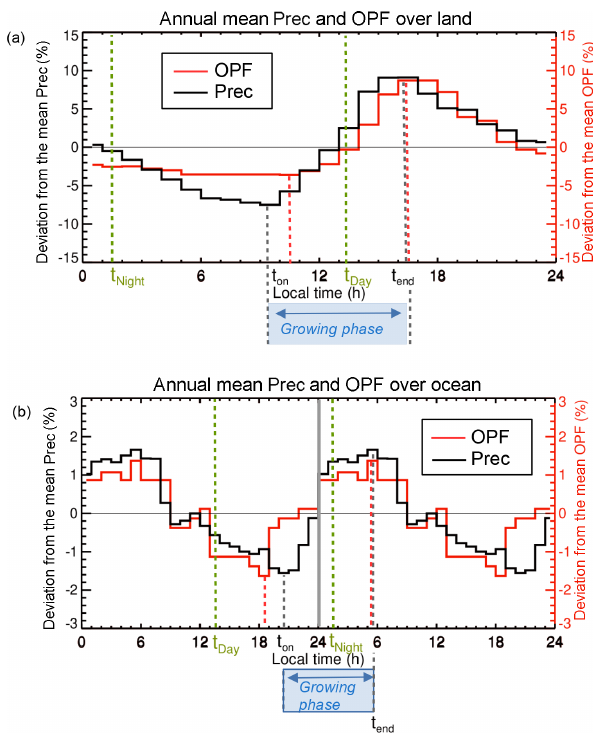
Figure 9. (a) Deviation from the mean of the annual mean diur- nal cycle of TRMM precipitation (Prec; black solid line) over land, from 2004 to 2017 and diurnal cycle of overshooting precipitation features (OPFs) at the tropopause (red solid line) over land, from 1998 to 2000 and from 2001 to 2003, adapted from Liu and Zipser (2005) over the tropics (20 ◦ N–20 ◦ S). (b) Same as (a) but over the ocean. Minimum and maximum Prec and OPFs are shown by verti- cal dotted lines (in black and red, respectively). t on is the time of the onset of the Prec, t end is the time of the diurnal maximum of Prec, and t day and t night are the times of the two MLS measurements at day and night,